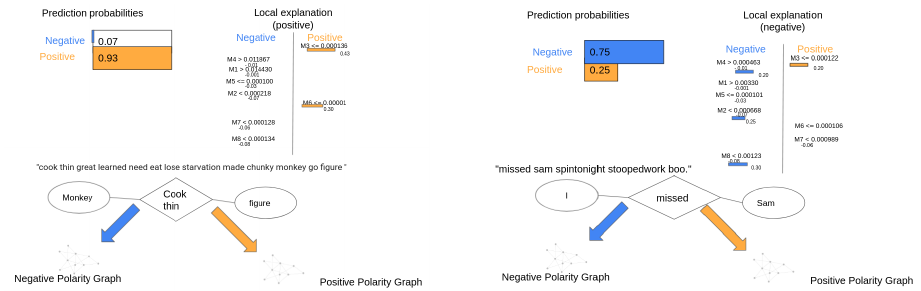
Figure 9. Local explanation of a positive and negative tweet, on the left and right,